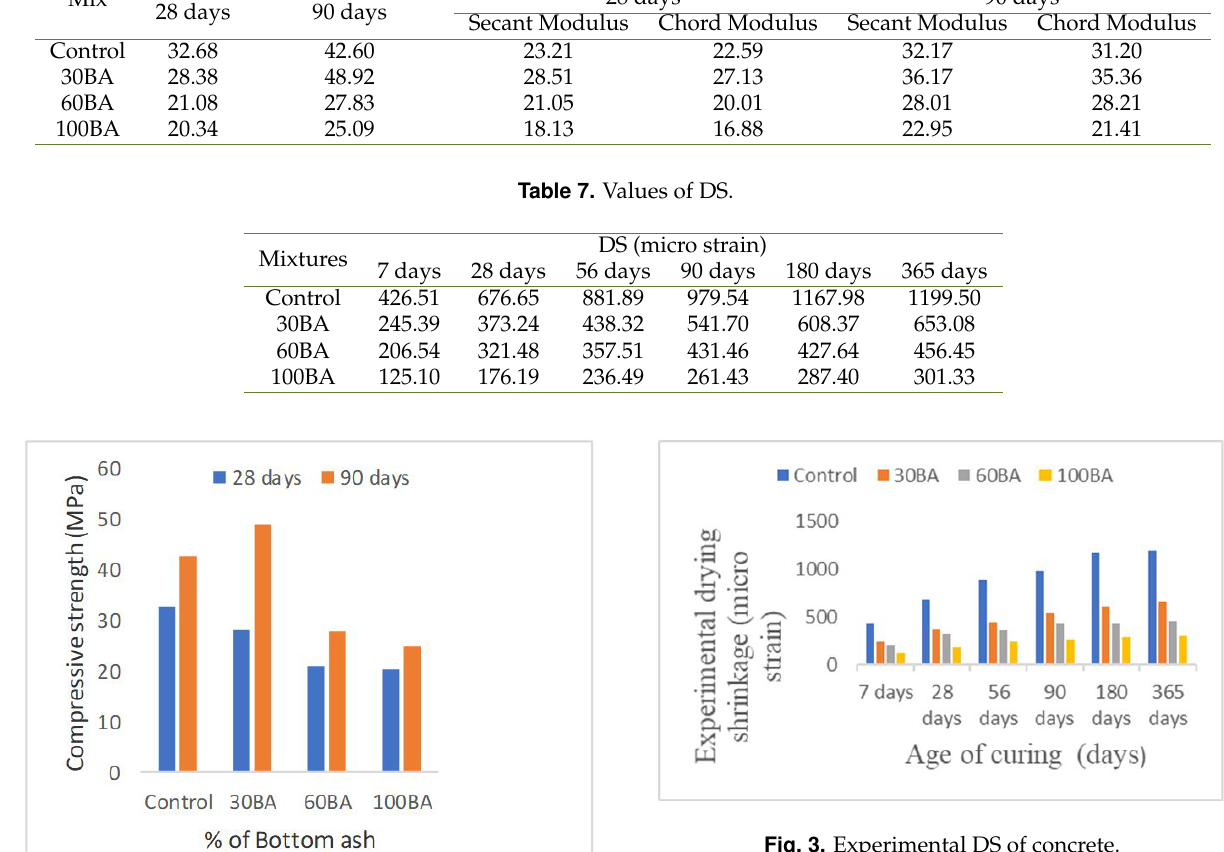
Fig. 3. Experimental DS of